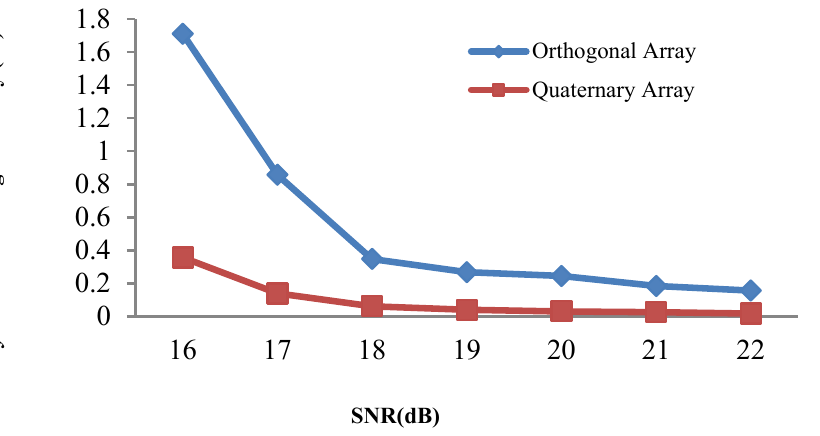
Figure 15. Comparison of the y-axis positioning accuracy of the Kalman filtering for different arrays